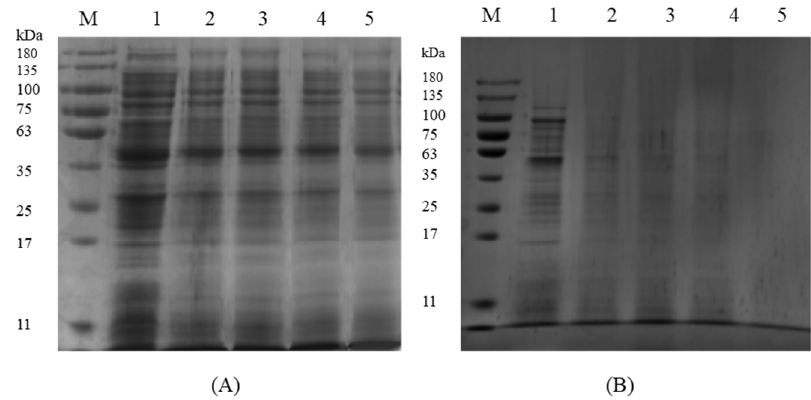
Figure 4. SDS-PAGE analysis of S. aureus ATCC 13565 proteins after treatment with ATCE at ( A ) 1 MIC and ( B ) 2 MIC. Lane M: marker. Lanes 1: control; Lanes 2, 3, 4, and 5: samples treated for 3, 6, 9, and 12 h, respectively.